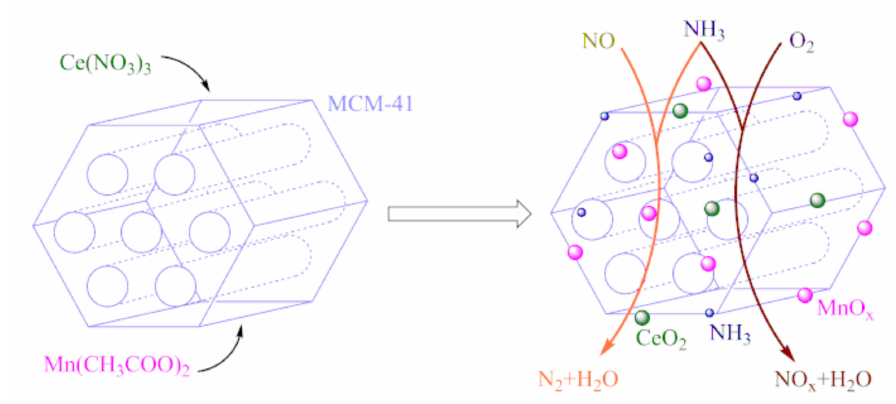
Figure 2. Schematic representation of catalyst preparation and SCR